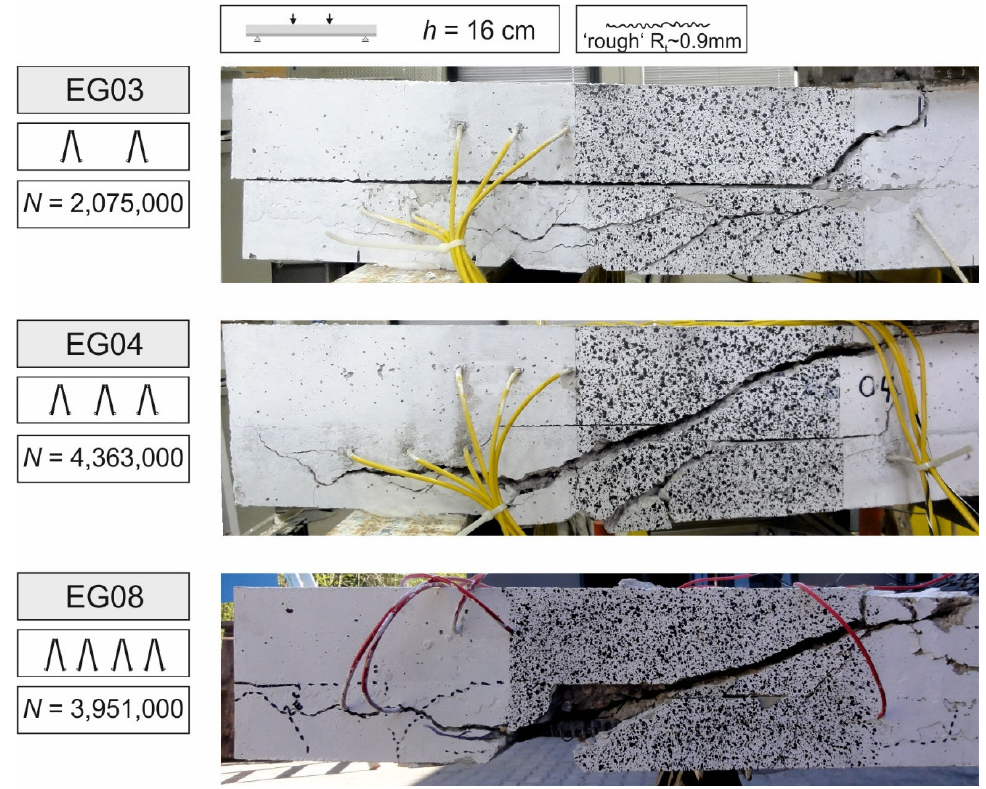
Figure 18. Comparison of interface reinforcement ratio: Crack patterns of Specimens EG03, EG04, and EG08.